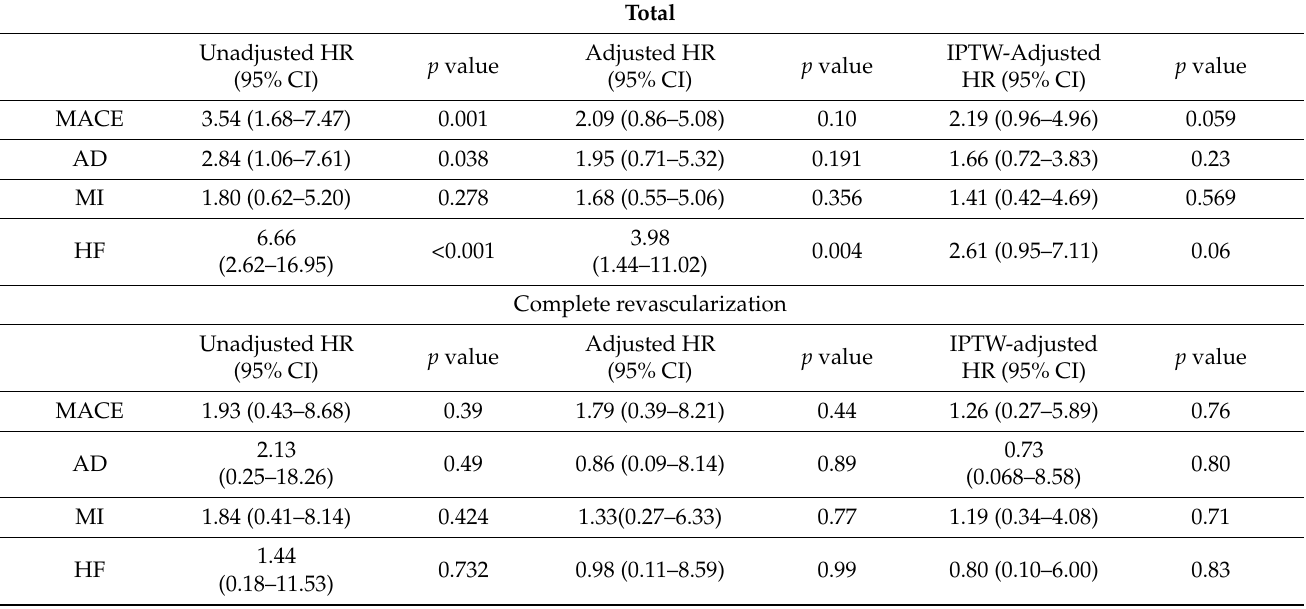
Figure 5. Kaplan – Meier curves for outcomes in patients who had incomplete revascularization. ( A ) Composite outcome of all-cause death, myocardial infarction, and readmission due to heart failure, thus MACE; ( B ) All-cause death; ( C ) Myocardial infarction; ( D ) Readmission due to heart failure. LVR = left ventricular remodeling; MACE = major adverse cardiovascular outcome; MI = myocardial infarction. Table 5. Cox proportional modeling and HR of LV remodeling in total population, complete revascu- larization, and incomplete revascularization